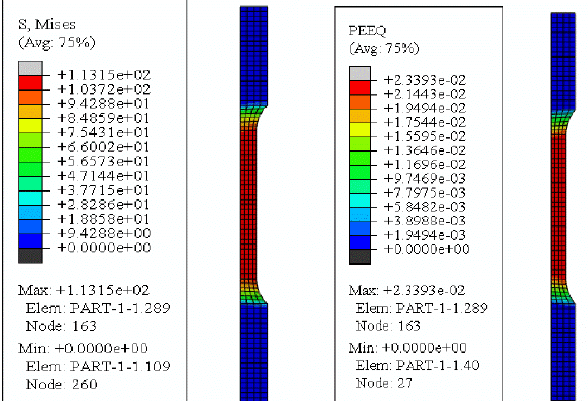
Figure 10. The ultrasonic vibration stage stress cloud.